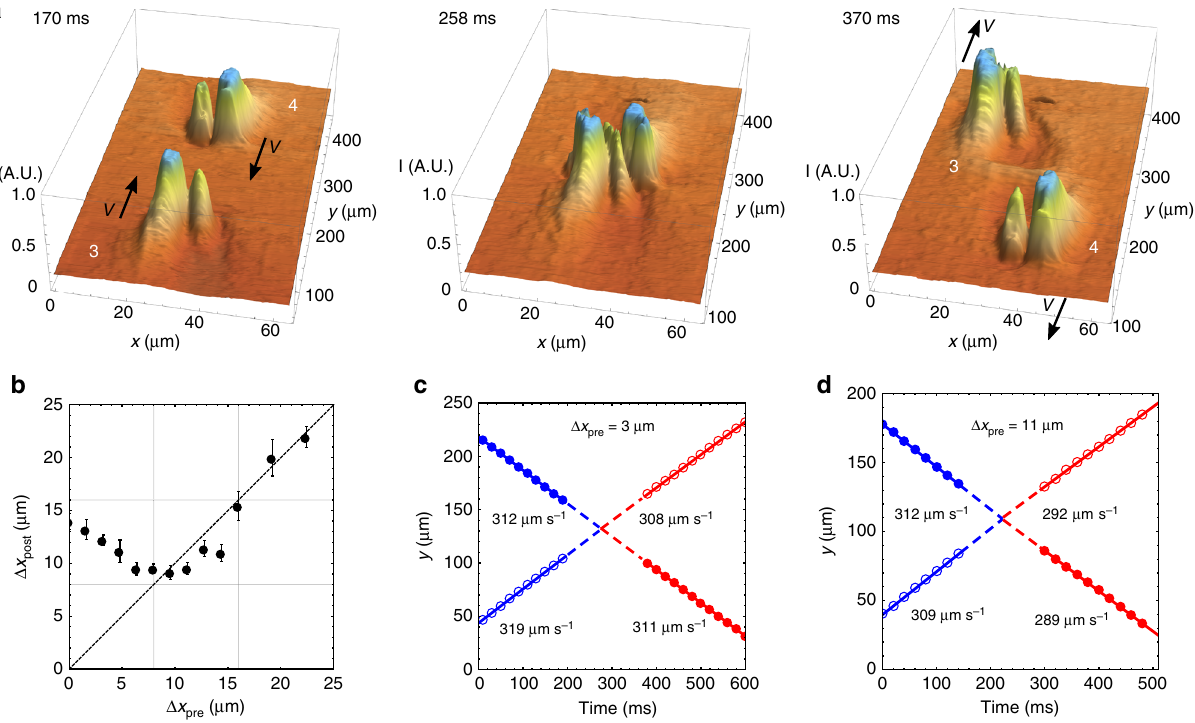
Fig. 7 Collisions and interactions of solitons. a 3D plots of transmitted light intensity through solitons “ 3 ” and “ 4 ” vs. x , y coordinates before, during, and after collision; Δ x pre < w /2; collision results in repulsion, Δ x post > Δ x pre ( U = 55.2 V, f = 800 Hz, T = 50 °C, d = 8.0 μ m). b Post-collision separation Δ x post as a function of the impact factor Δ x pre ( U = 54.8 V, f = 400 Hz, T = 45 °C, d = 8.0 μ m). c Time dependence of the y -coordinates of two colliding solitons, with Δ x pre < w /2; U = 52.1 V, f = 450 Hz, T = 45 °C, d = 7.5 μ m. d The same dependence for solitons with w /2 < Δ x pre < w ; the same experimental conditions as in c . The lines represent linear fi tting used to calculate the velocities indicated in the fi